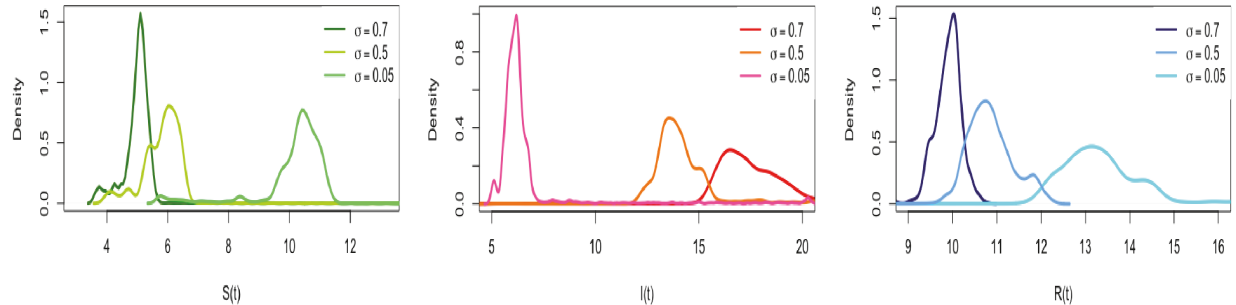
Figure 2: Computer simulation of the density function of the invariant stationary distribution of system (3) with different values of 𝜎 and the parameters values Λ = 2 , 𝛽 = 0.02 , 𝜇 1 = 0.066 , 𝜇 2 = 0.066 , 𝜇 3 = 0.0666 , 𝛼 = 0.16 , 𝜎 1 = 0.021 , 𝜎 2 = 0.02 , and 𝜎 3 = 0.023. In this situation R = 2,66 > 𝑇